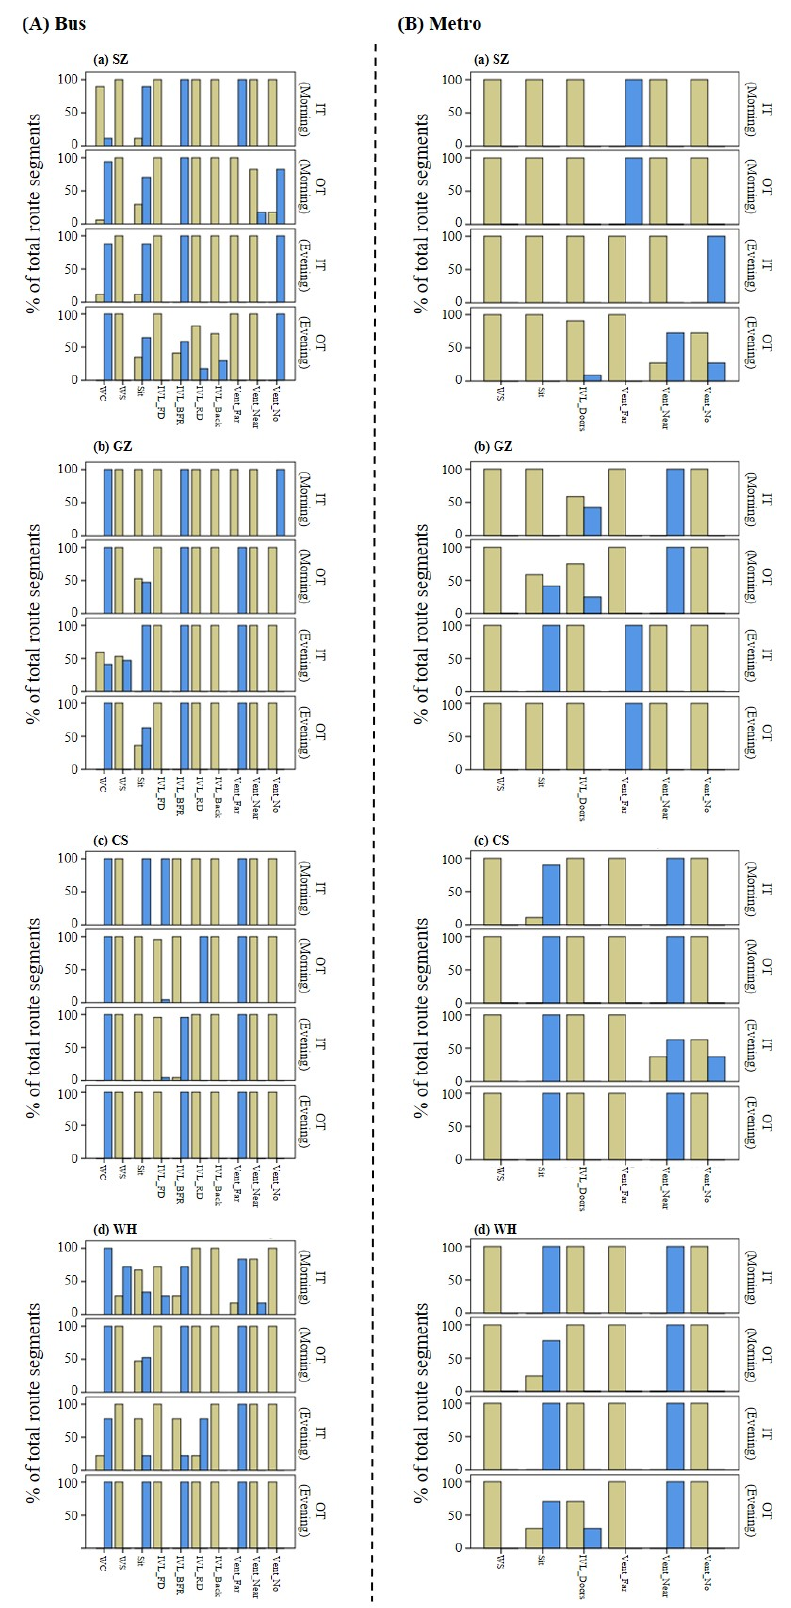
Figure 4. Percentage of bus route segments ( A ) and metro route segments ( B ) within each category of in-cabin transit conditions during a trip. ( a – d ) represent the city of SZ, GZ, CS, and WH, respec- tively.